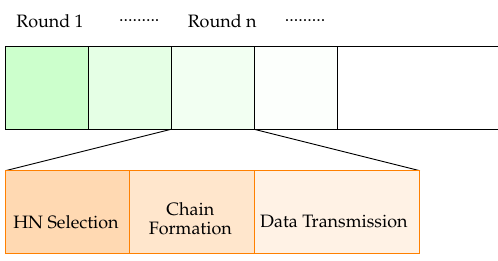
Figure 4. Network with corona, wedge and sector.